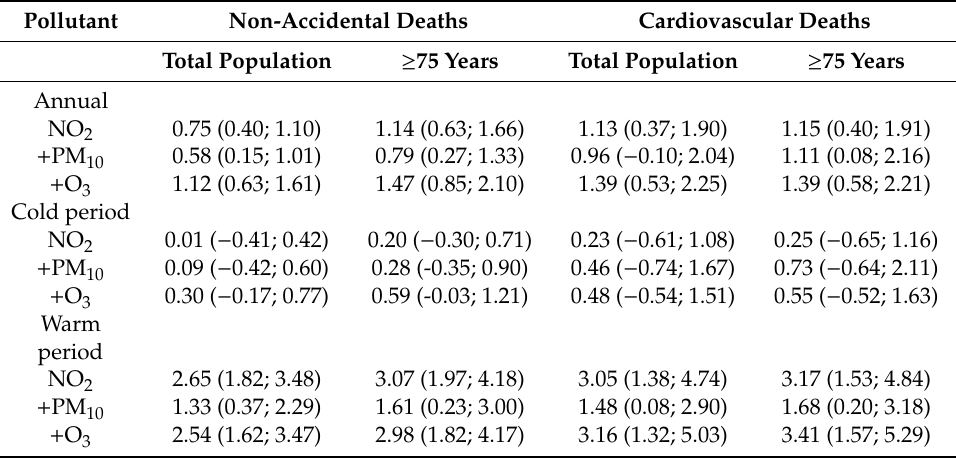
Table 4. Excess relative risk (ERR) and 95% confidence intervals (95% CI) of non-accidental and